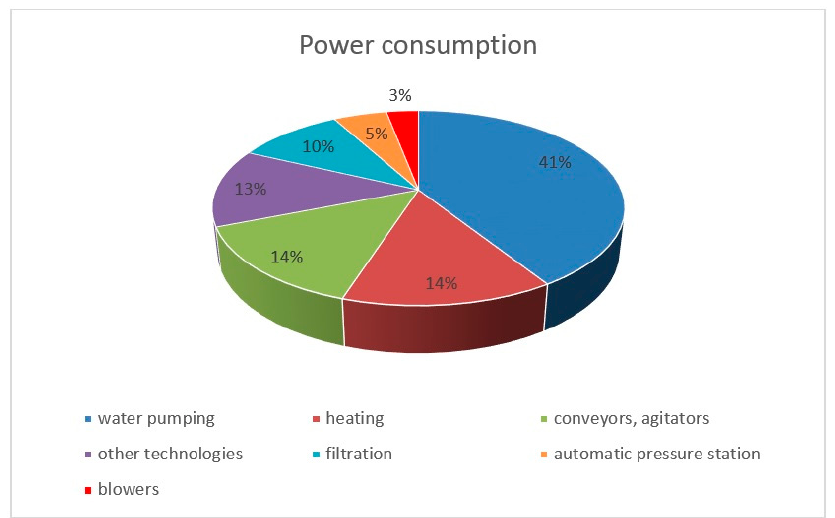
Figure 3. Water treatment plant’s power consumption.